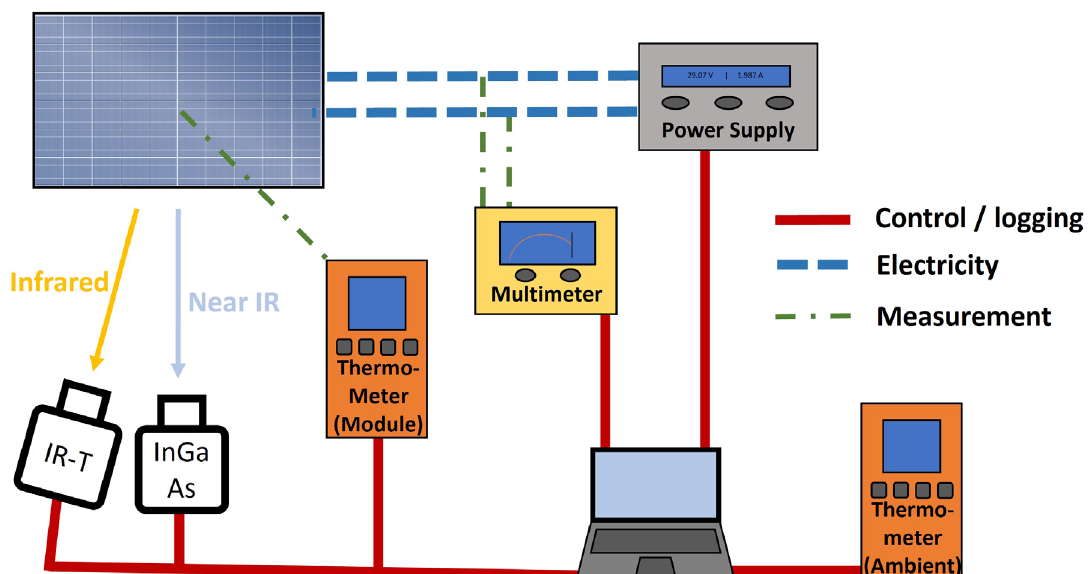
Fig. 1. Schematic of the experimental setup to survey the heating of a PV module during EL